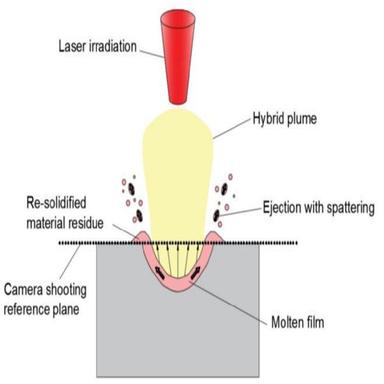
Illustration for hole-drilling using millisecond laser irradiation.